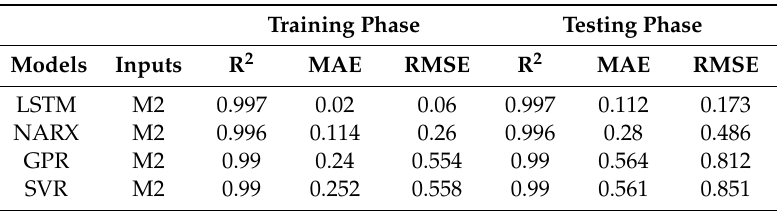
Table 5. Performance evaluation of data-driven models.